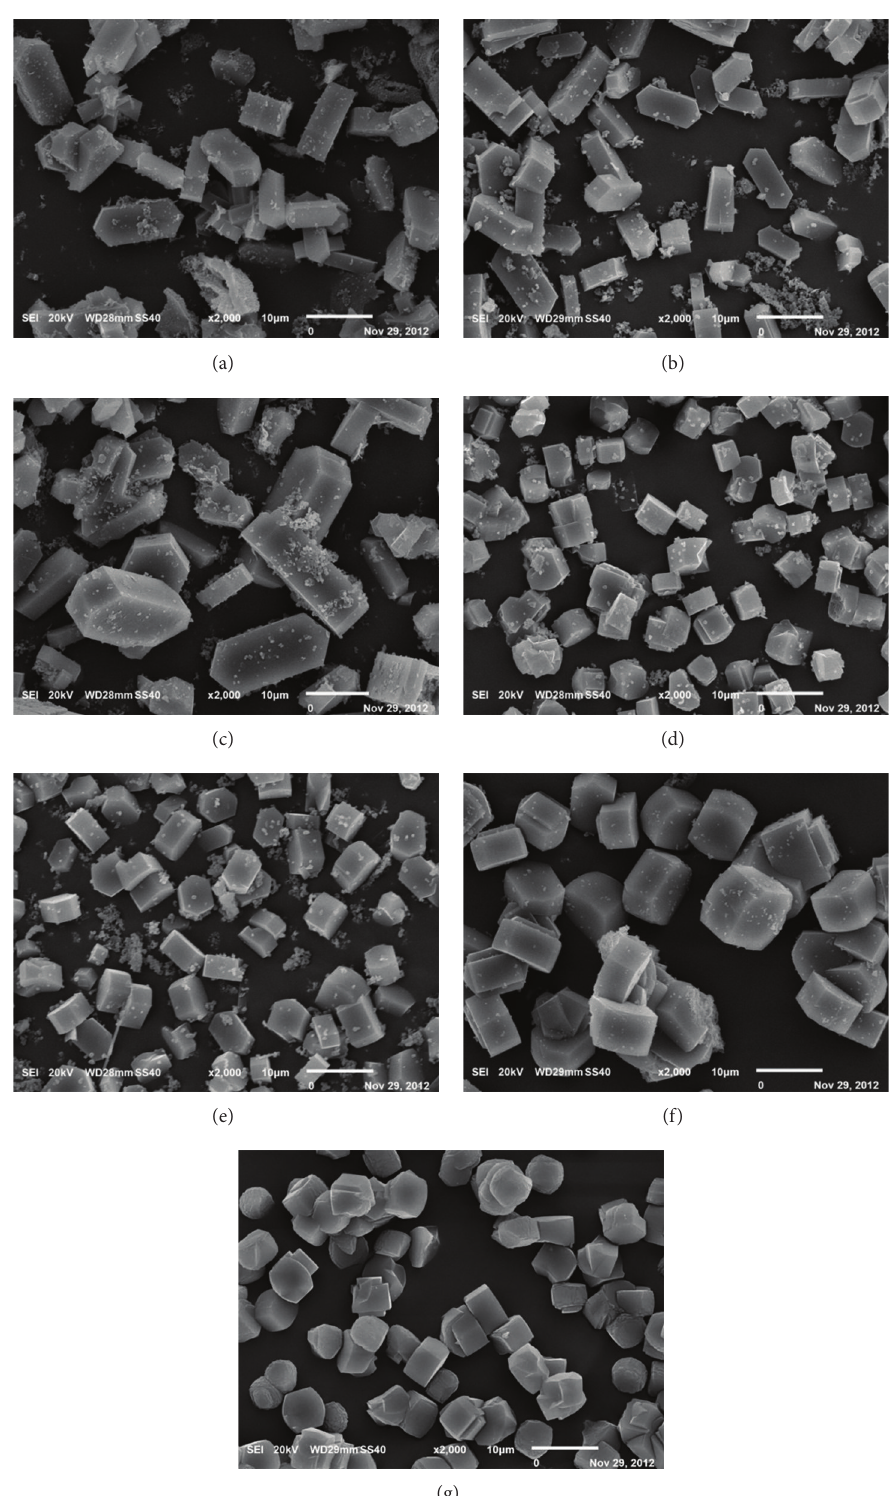
Figure 3: Scanning electron micrographs of as-synthesized silicalite prepared from RHA and SG under the synthesis conditions in Table 2: SL1 (a), SL2 (b), SL3 (c), SL4 (d), SL5 (e), SL6 (f), and SL7